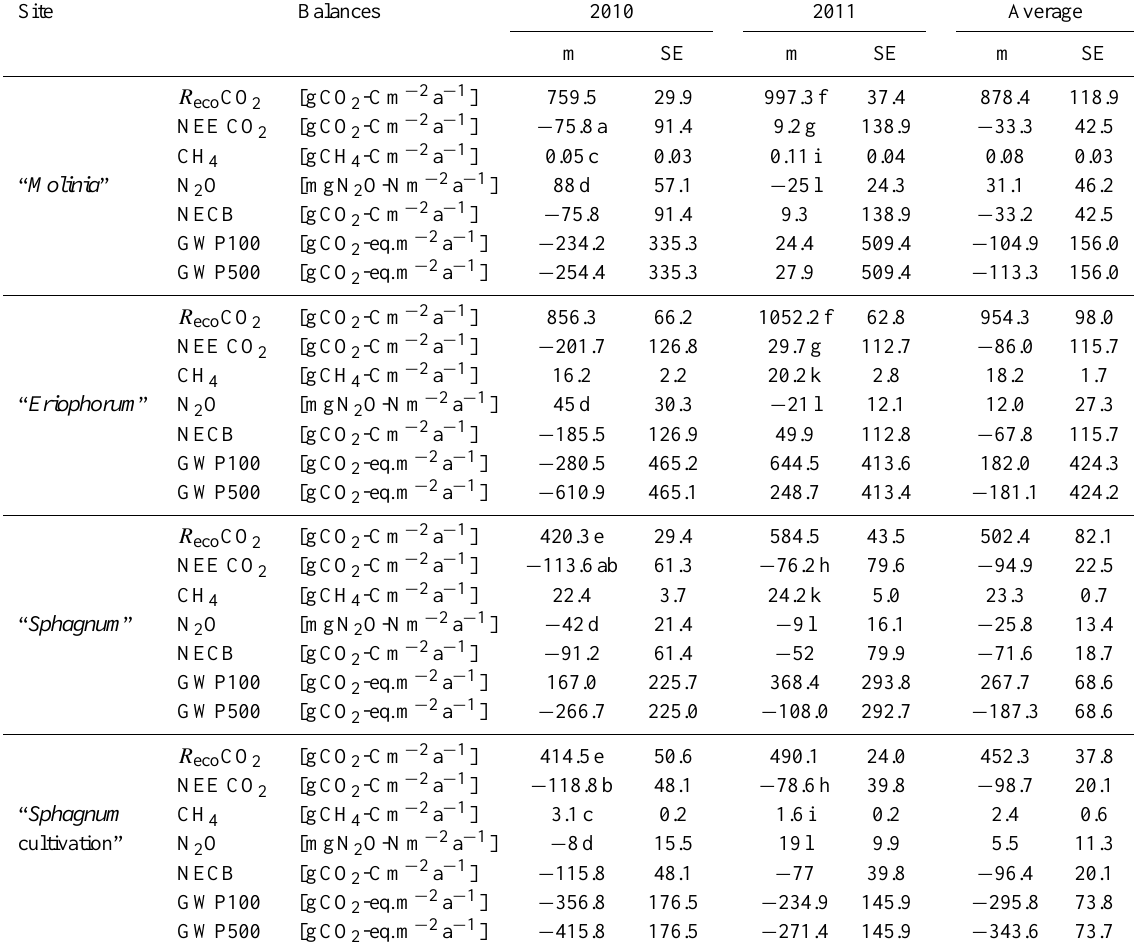
Table 2. Annual and average balances for R eco , NEE, CH 4 -C, N 2 O-N exchange, NECBs (net ecosystem carbon balances) and GWP (global warming potential for the time spans of 100 and 500 years) balances; m: mean; SE: standard error. Letters indicate that balances are not significantly